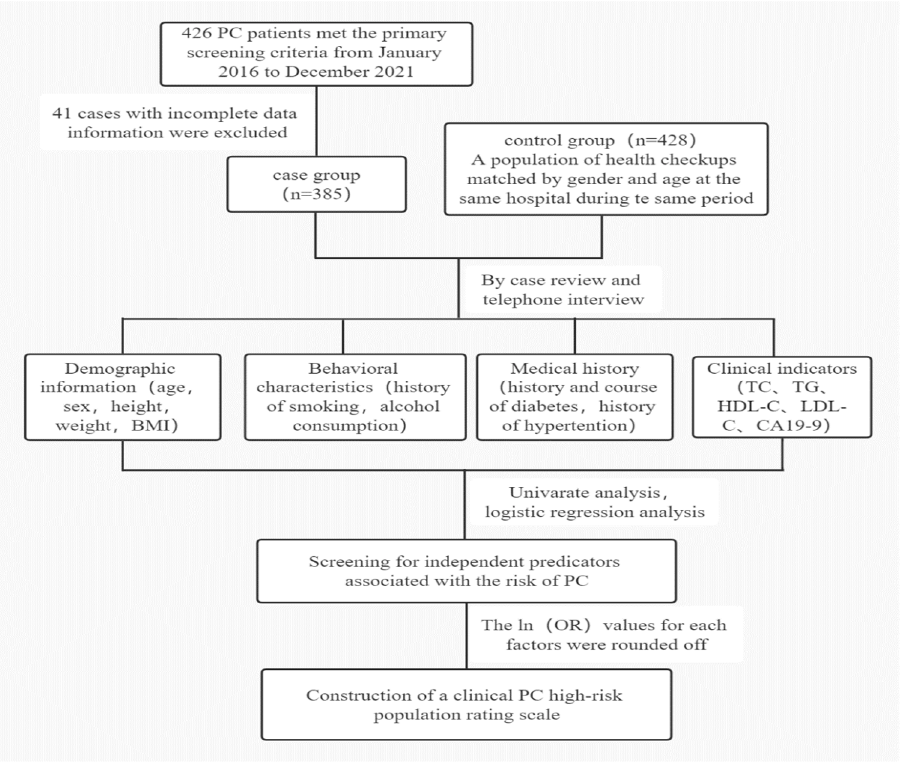
Figure 1. Study Design Flow Chart. PC: Pancreatic cancer; TC: Total cholesterol; TG: Triglycerides; HDL-C: High-density lipoprotein cholesterol; LDL-C: Low-density lipoprotein cholesterol; CA19-9: Carbohydrate antigen 19-9.